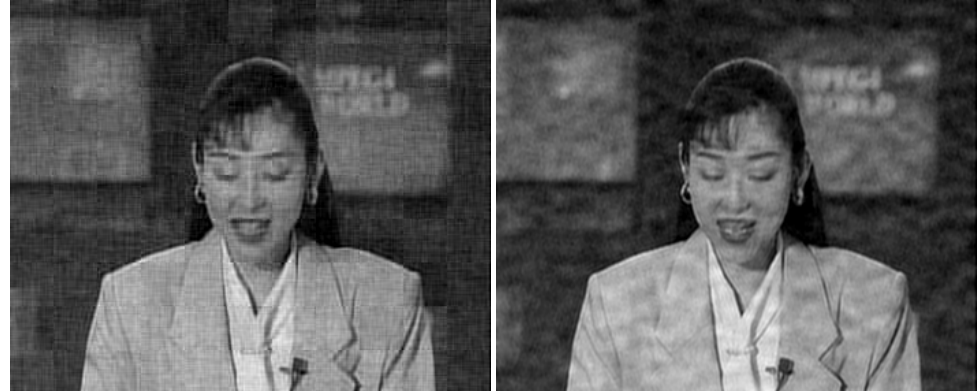
Figure 15. “Akiyo” frames received from a transmission with a bandwidth ratio of 0.1 and a SNR of 10dB. Left-hand side : JSCC-Cast with SSIM quality of 0.67. Right-hand side : Softcast with SSIM quality of 0.76.